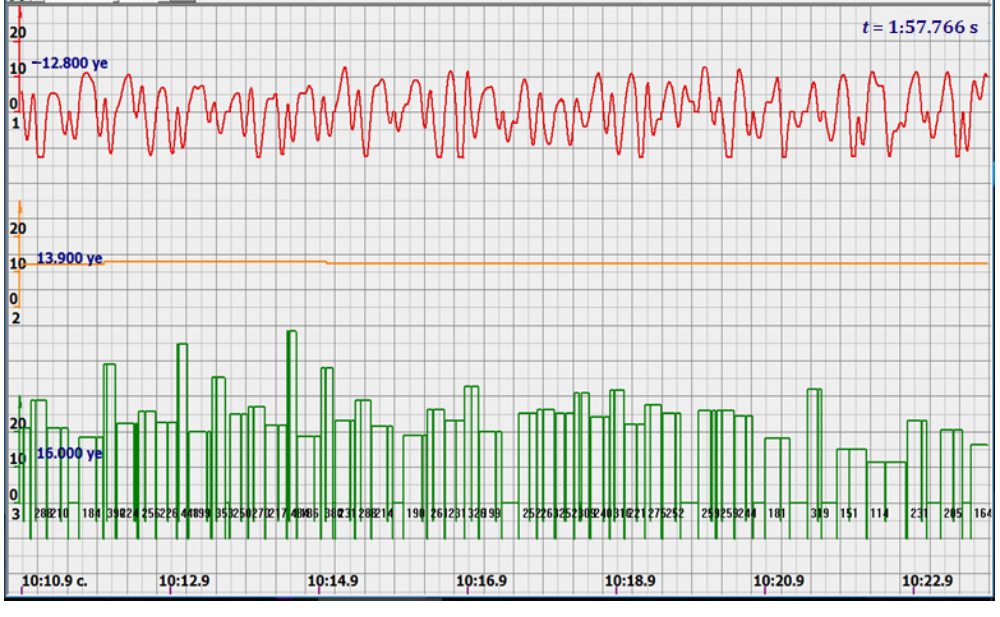
Figure 10. Heart rate intervals are divided by vertical lines into positive and negative half-waves in proportion to the duration of these half-waves.